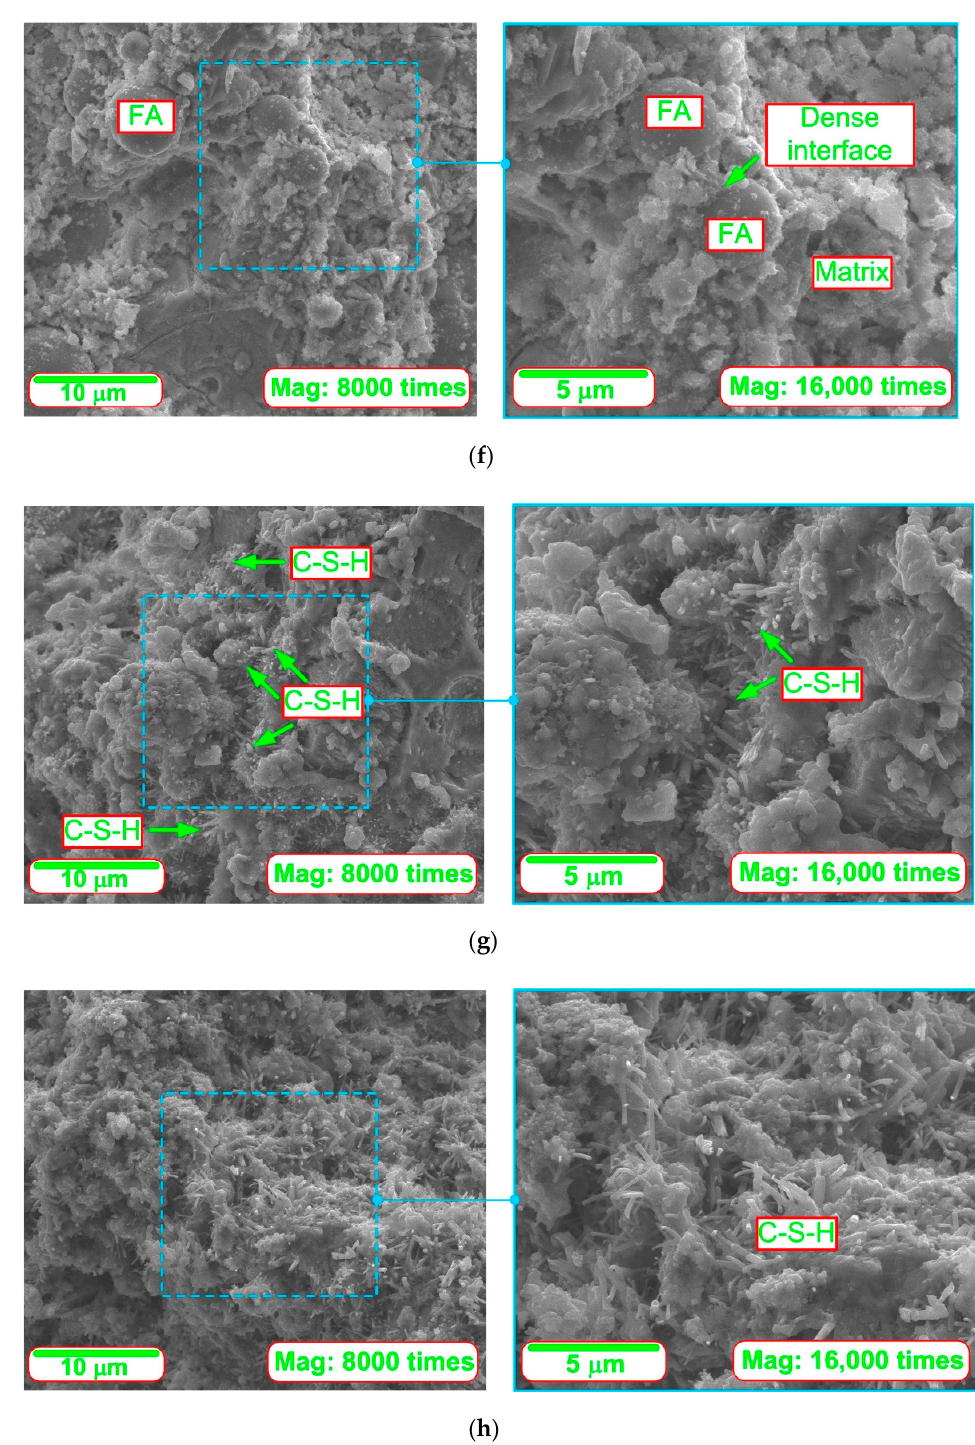
Figure 4. SEM micrographs of analyzed composites including FA in particular periods of curing: ( a ) 20FA0NA—4 h of curing, ( b ) 20FA4NA—4 h of curing, ( c ) 20FA0NA—8 h of curing, ( d ) 20FA4NA—8 h of curing, ( e ) 20FA0NA—12 h of curing, ( f ) 20FA4NA—12 h of curing, ( g ) 20FA0NA—24 h of curing and ( h ) 20FA4NA—24 h of curing.